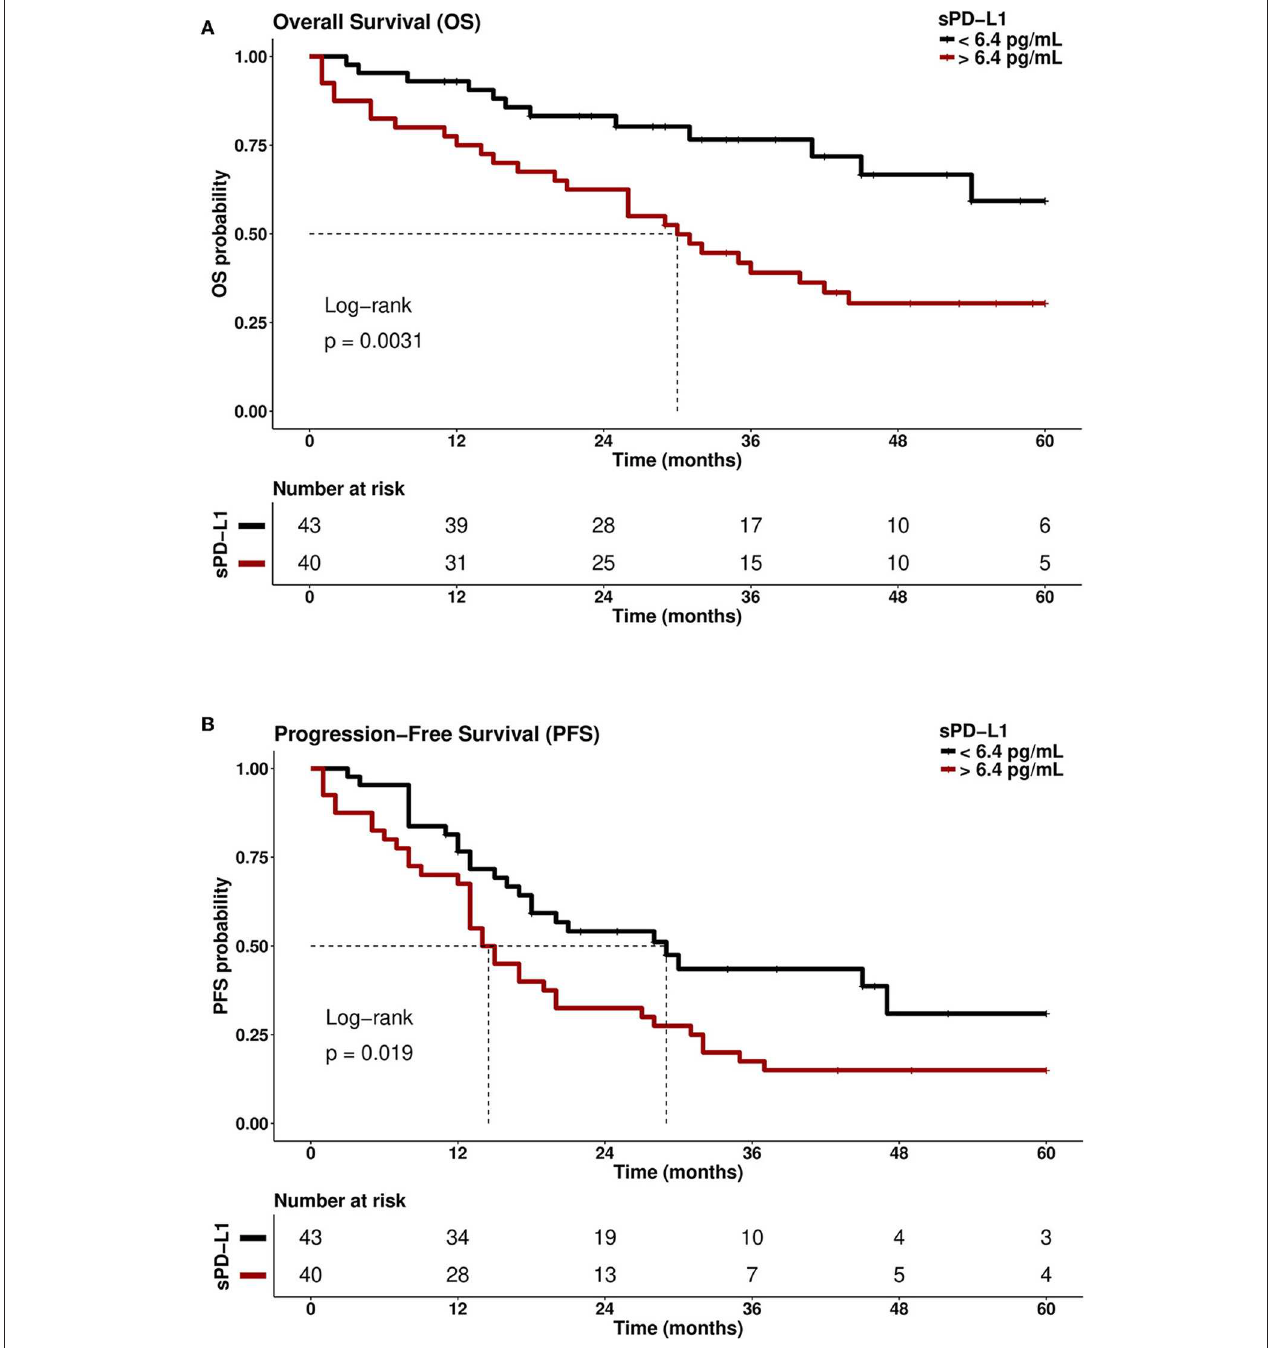
FIGURE 5 | Kaplan-Meier curve of survival probability with respect to sPD-L1 serum levels (pg/ml). Patients with high sPD-L1 serum levels ( > 6.4pg/mL) had a reduced (A) overall survival (OS; p = 0.0031) and (B) progression-free survival (PFS; p = 0.019) compared with patients who had low sPD-L1 levels ( < 6.4pg/ml). Time was calculated from blood sampling to event (death/progression) or last follows up. Dotted line indicates the median survival time of EOC patients in the respective group.